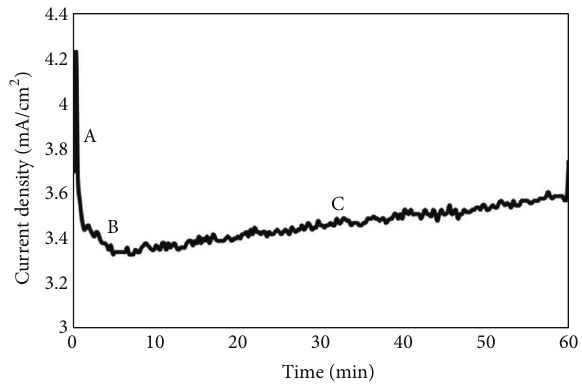
Figure 3: Current density versus duration response during the electrochemical anodization for 60 minutes at 40 V in 1M Na 2 SO 4 containing 0.5 wt% NH 4 F.